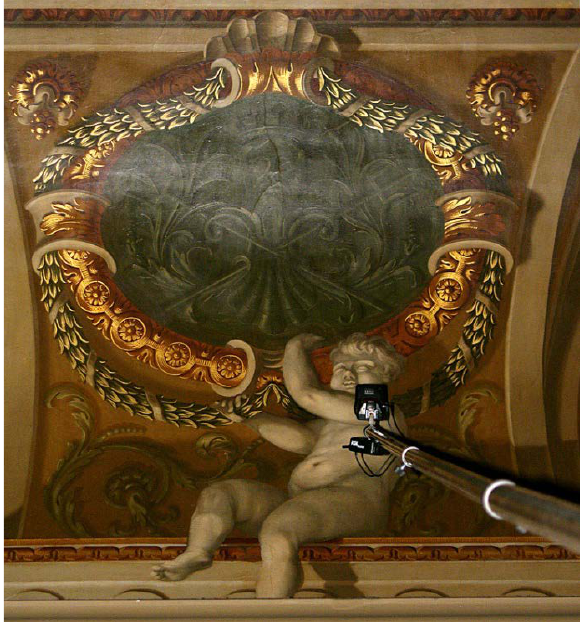
Figure 2. Upward view of flash mounted on top of 8m